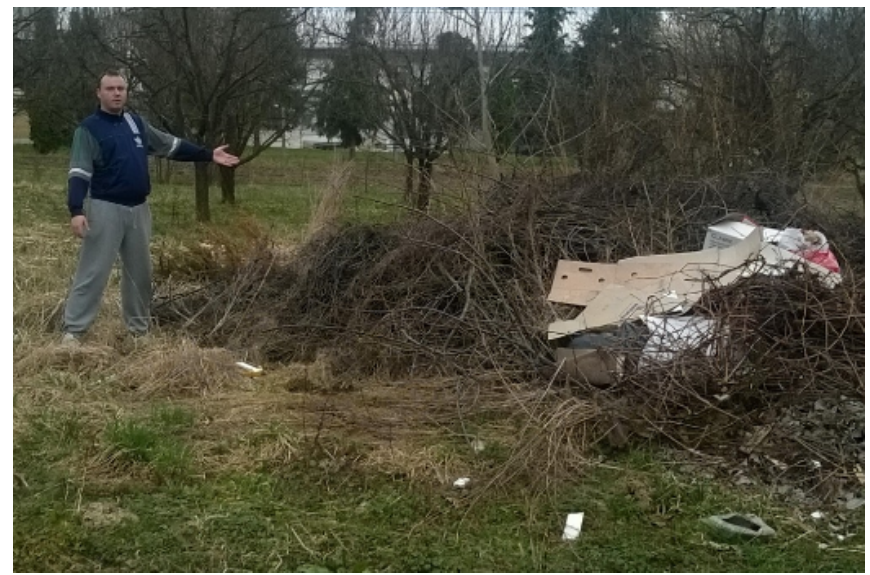
Figure 8. Example of a pile of residual branches in the Danube